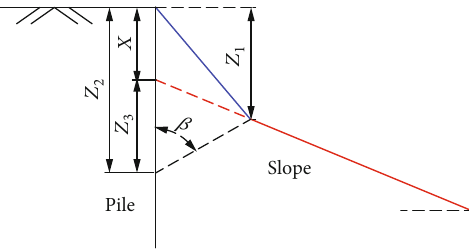
Figure 6: Initial sti ff ness model of slope